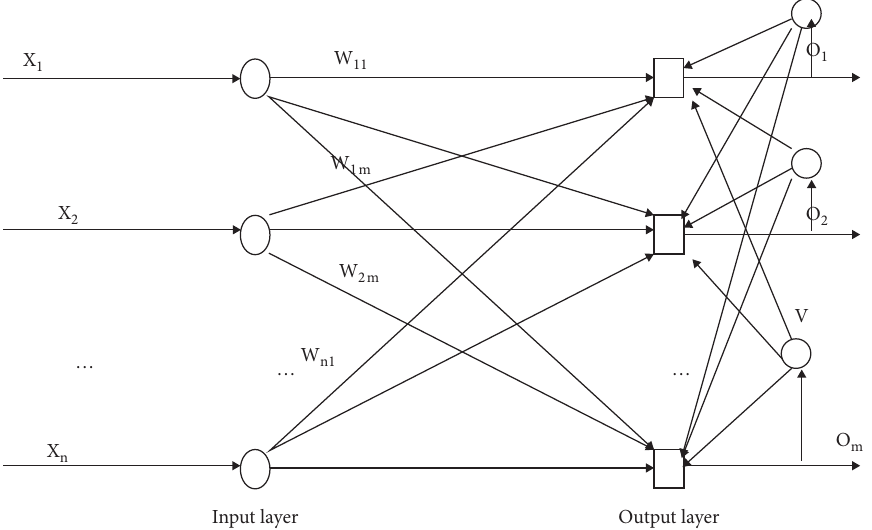
Figure 7: Topology of BP network